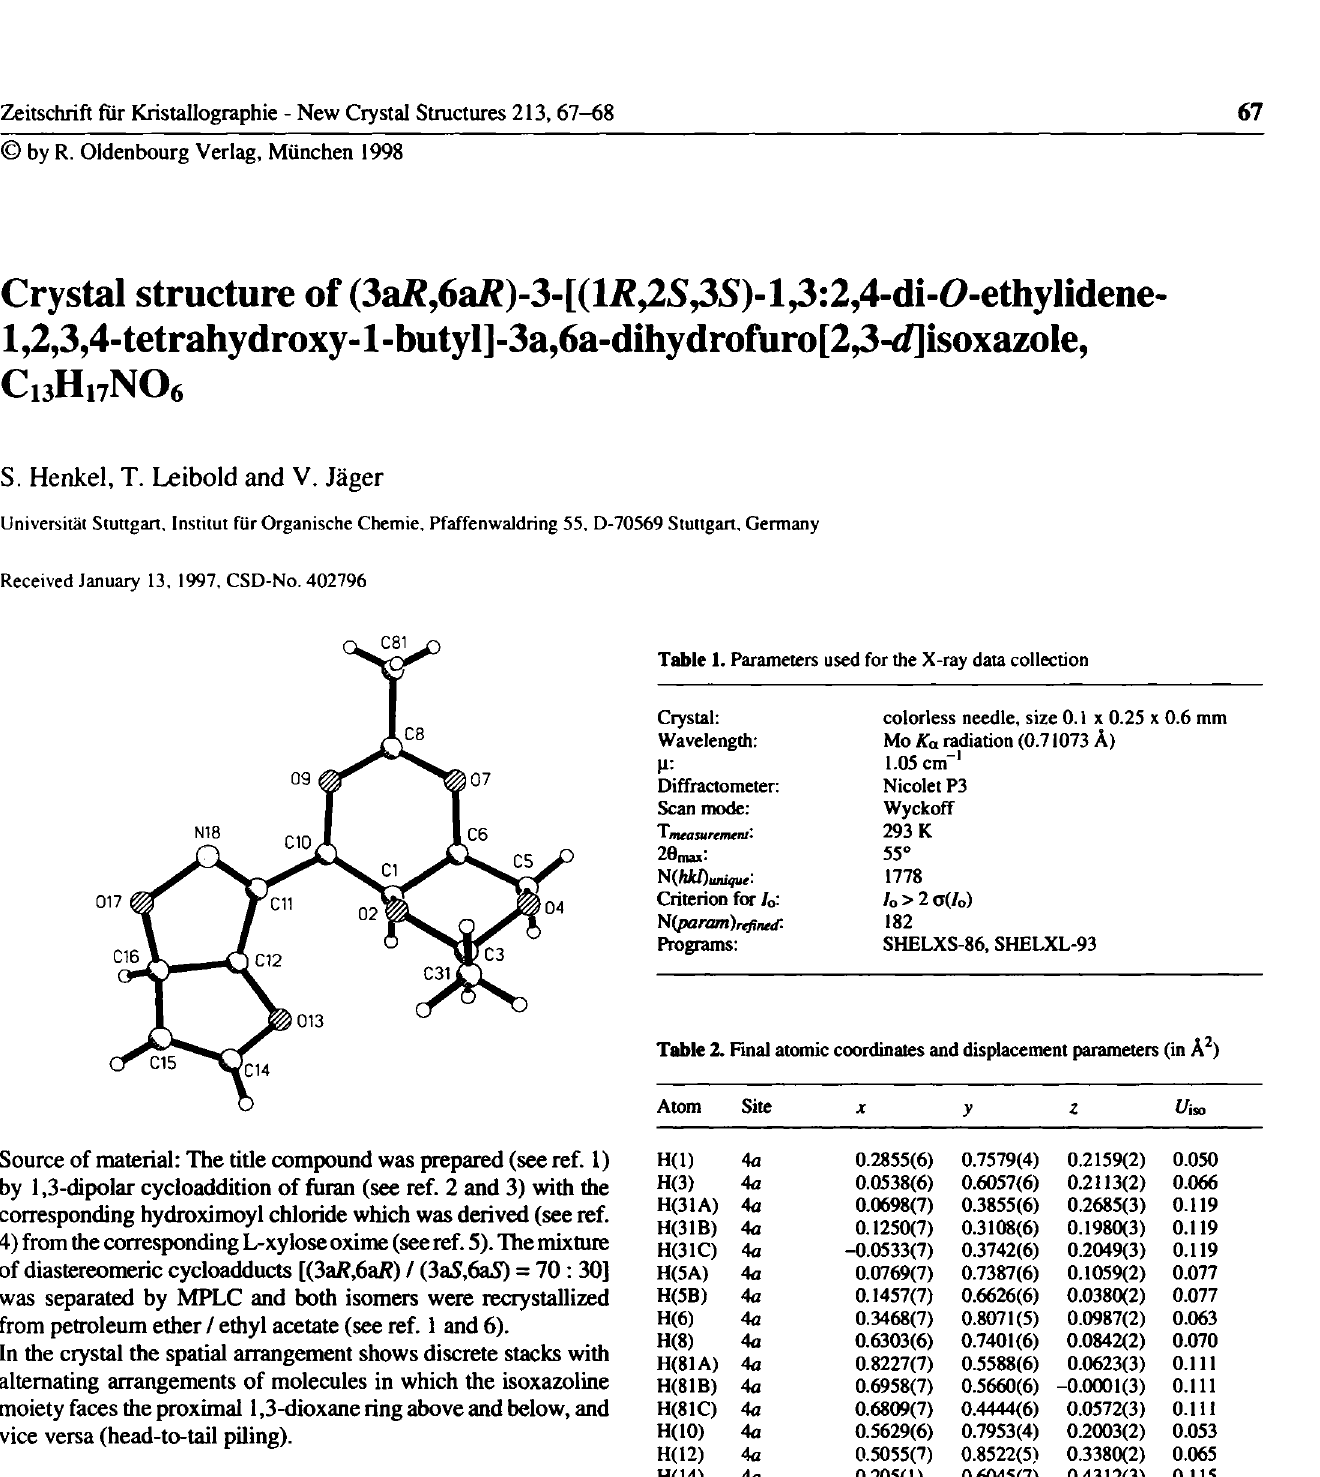
Table 3. Final atomic coordinates and displacement parameters (in À^) Atom